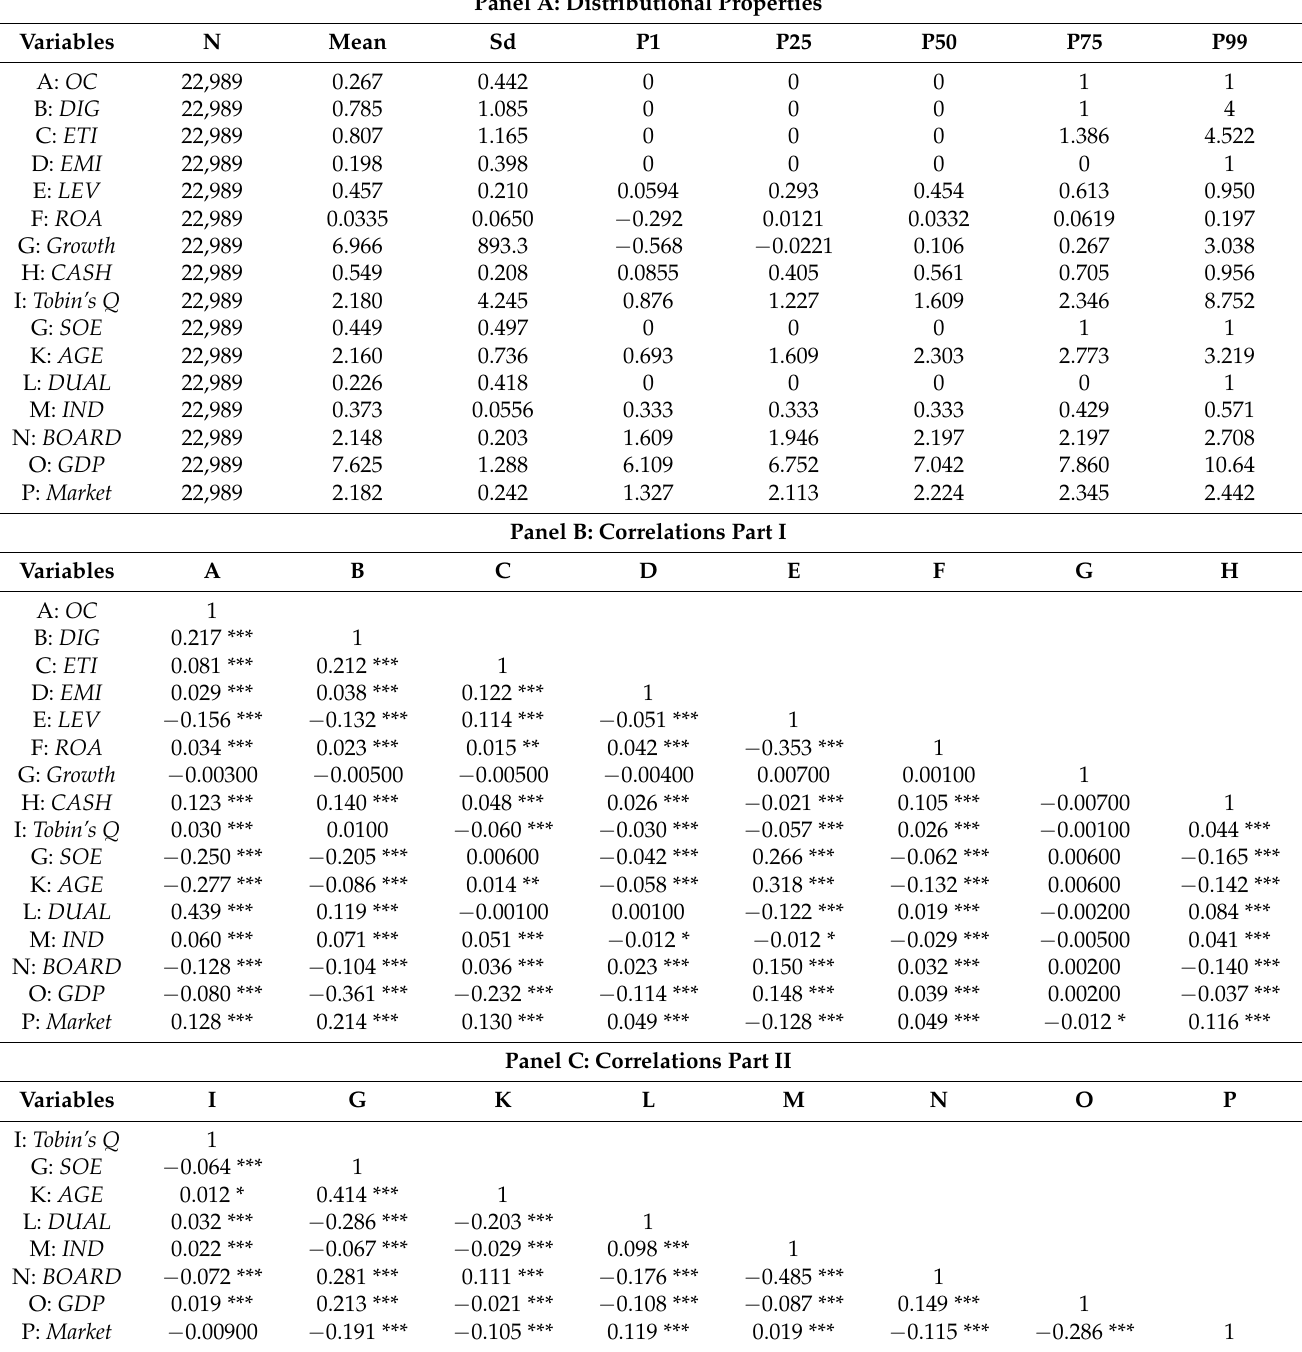
Table 3. Summary and correlation statistics. Panel A: Distributional